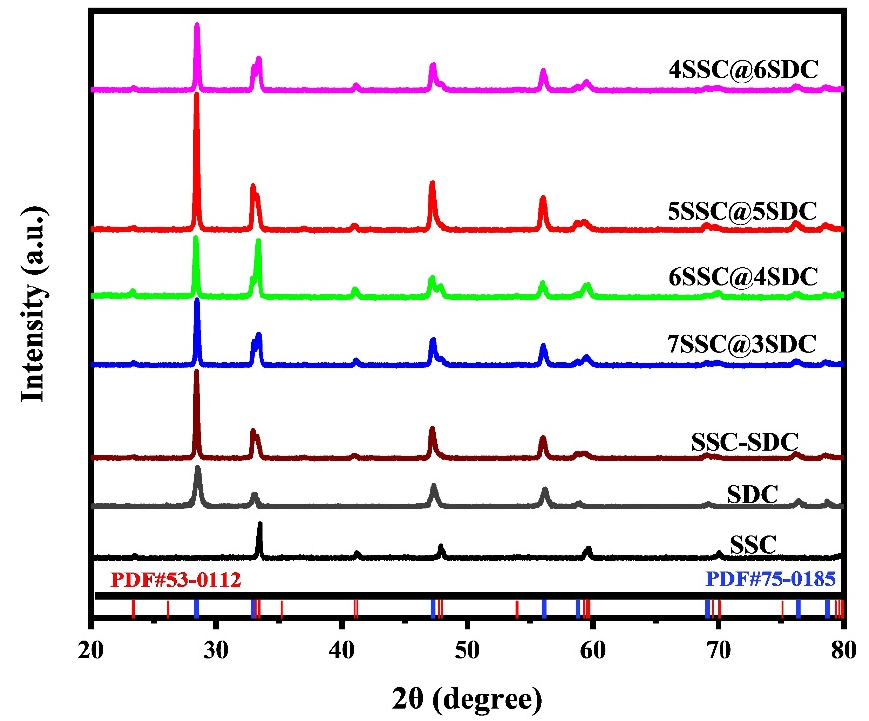
Figure 3. XRD patterns of pure SSC, pure SDC, physically mixed SSC-SDC and 10-xSSC@xSDC (x = 3, 4, 5, 6) after firing at 850 °C for 2 h.